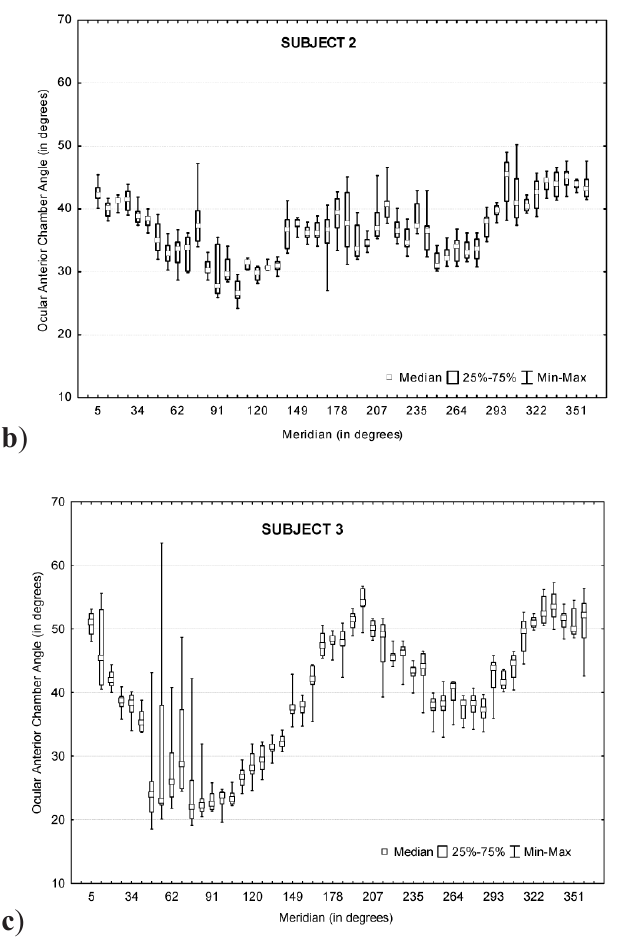
Figure 1. Box and whisker plots of the medians (small boxes) and quartile ranges (larger rectangles) for the ocular anterior chamber angles (ACA) for the different meridians of the right eyes of three young, female subjects. All measurements of ACA were obtained using the Oculus Pentacam repeatedly within each subject ( N =10 maps per right eye) over a short time period. Maxima and minima for individual meridians are also indicated using the whiskers and possible outliers are present for a few meridians, such as near 60 0 in Subjects 1 and 3. But, excluding these few meridians where outliers were possibly relevant, the within-meridian or intra-meridional variances in ACA are rela- tively small for each subject. That is, each quartile range (also called the inter-quartile range ( Q 1 and Q 3 ) and essentially the width of the range about the median concerned including 50% of the cases) was mostly small. a) Subject 1, b) Subject 2 and c) Subject 3